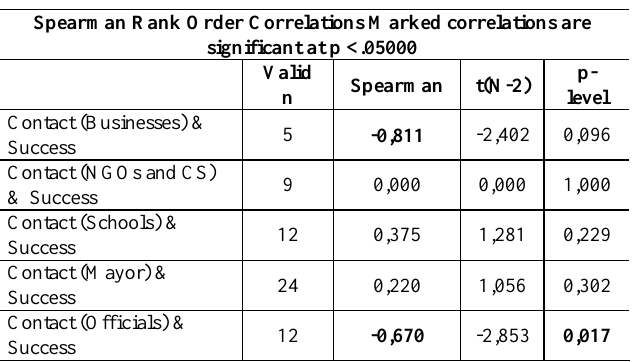
Table 6: Frequency of contact and alliance success